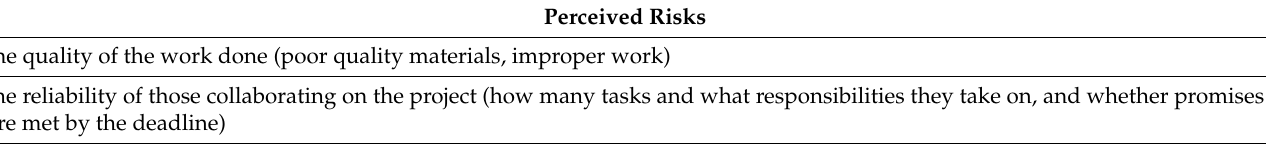
Table 3. Project risk factors perceived by participants in the architectural investment project process. Source: authors’ own research, 2018. N = 52